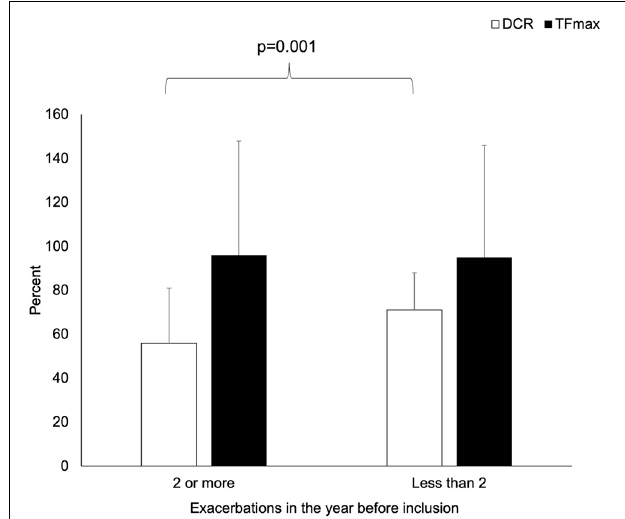
FIGURE 1 | Comparison of the values of TFmax and DCR among CF patients according to acute exacerbation frequency in the year before